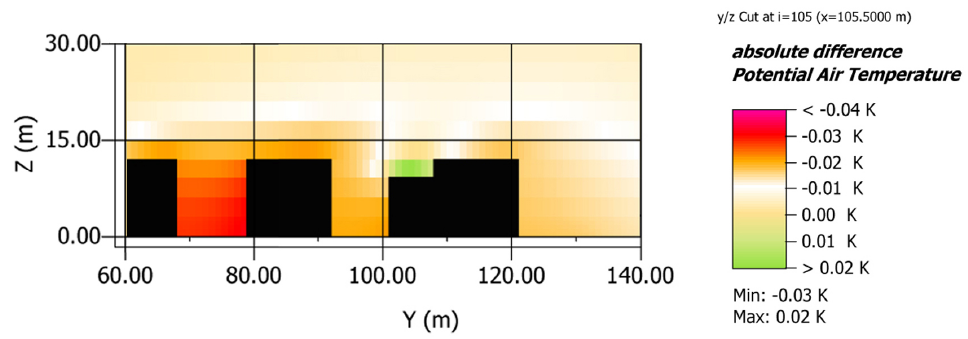
Figure 16. The initial state and green roof air temperature difference comparison in vertical cross section on the north-south axis with the west side view; the atrium is on the right part of the picture. Figure by authors.